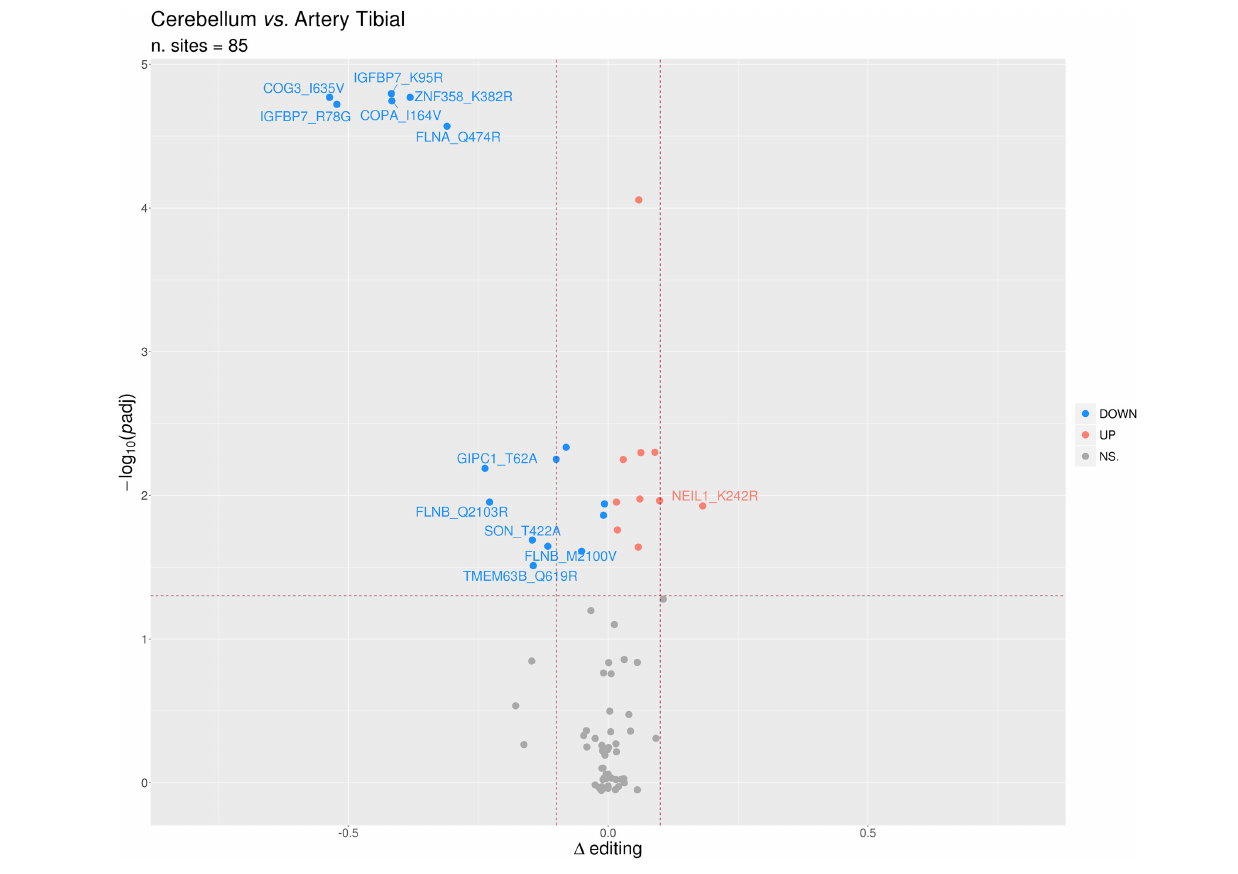
Frontiers in Genetics |